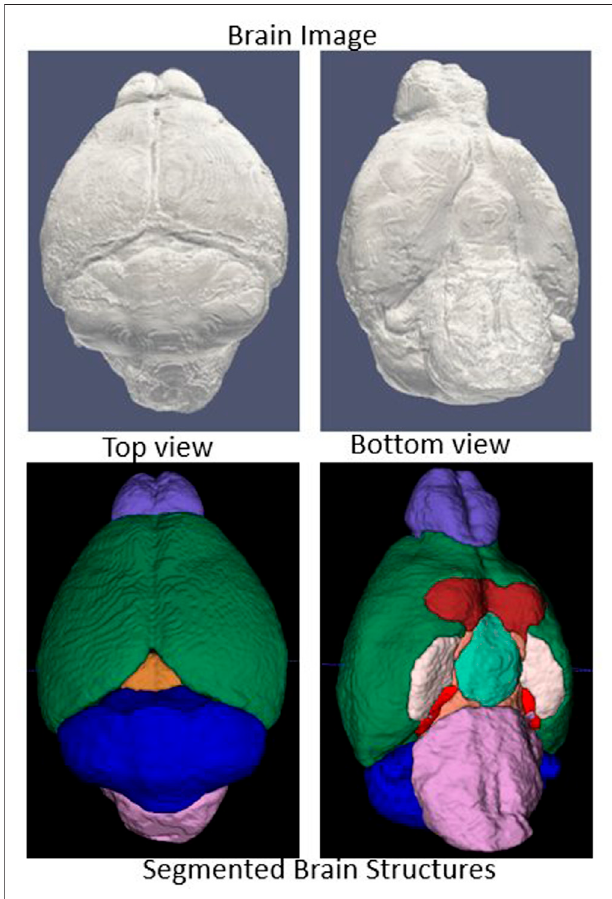
FIGURE 2 | Segmentation outcomes: Top row: Segmented brain surface. Bottom row: Segmented large brain regions (blue color: cerebellum, Green color: fore brain, violet color: olfactory bulb, orchid color: brain stem).